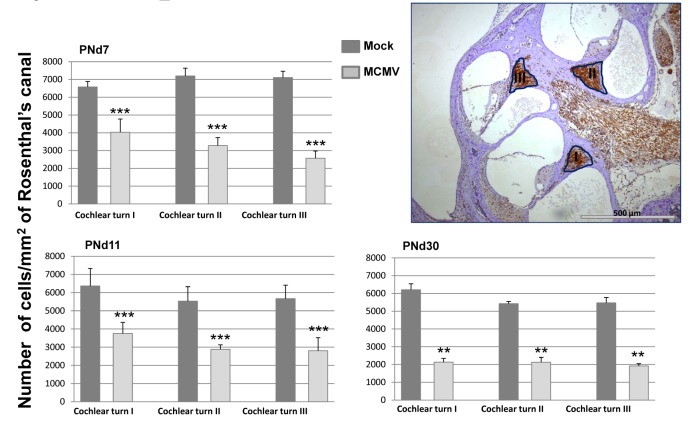
Loss of spiral ganglion neurons in mice infected in newborn period with MCMV.Mice were sacrificed at various postnatal days (PNd) 7, 11, and 30 as described in the Material and Methods. For each time point, cochlea were removed and placed in 4% paraformaldehyde, decalcified and embedded in paraffin as described in Materials and Methods. Sections were stained with anti-Tuji 1 antibodies to detect neurons followed by horseradish peroxidase (HRP) conjugated second antibody and development with diaminobenzidine (brown). Cresyl violet (CV) was used as counterstain. Digitalized images, of the inner ear from each individual tsection (2 per cochlea) were imported into the B-Cell Image program. Spiral ganglion cell (SGC) densities were calculated in infected animals (4 mice per time point) and mock infected animals (3 mice per time point) by determining the number of spiral ganglion neurons followed by normalization to the area of Rosenthal’s canal in each section to provide the spiral ganglion neuron density (cells/mm2). Spiral ganglion neuron densities in the basal, mid and apical turns (I, II, III) of the cochlea are presented as the mean number of neuron density with error bars demarcating SEM (** indicates significant differences p<0.0022, and *** p<0.001 by Mann-Whitney).